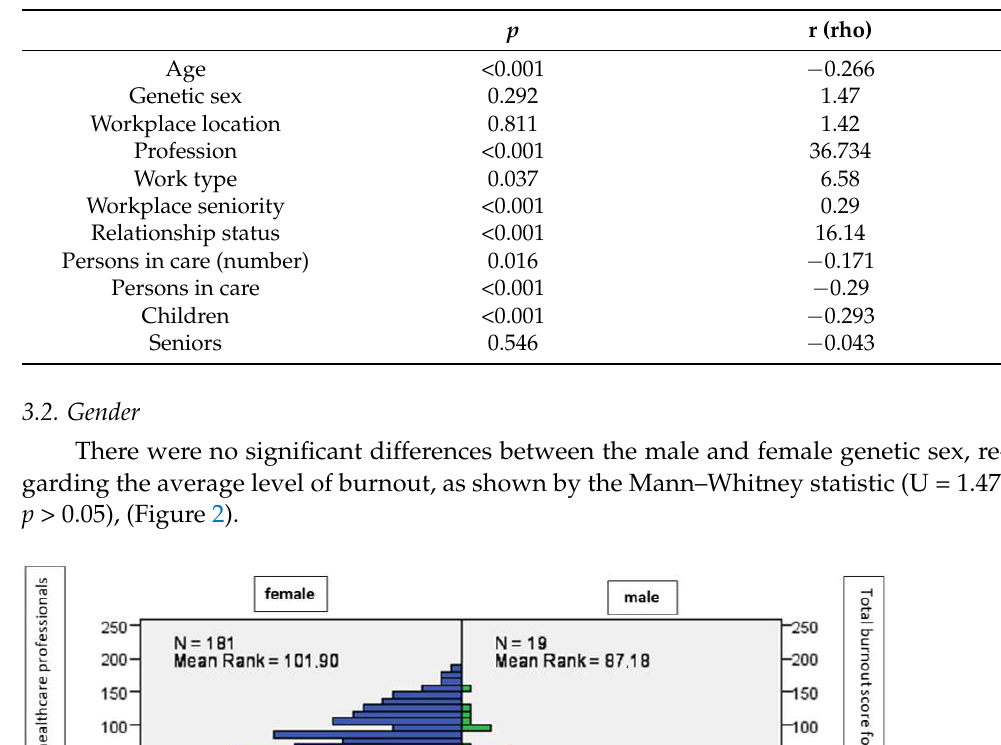
Figure 2. The average level of burnout according to gender.